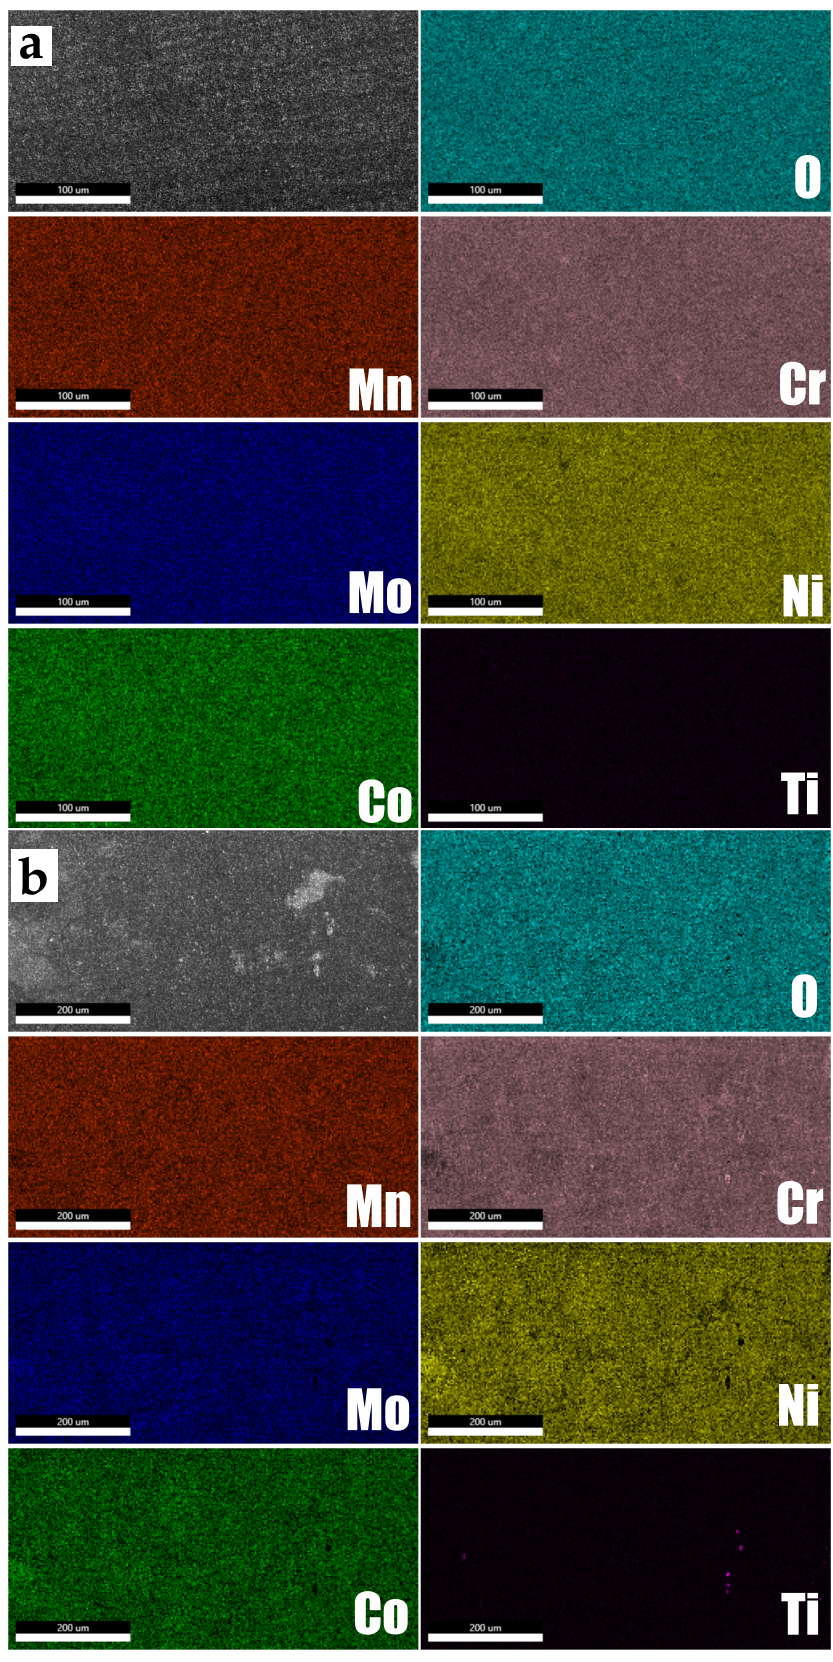
Figure 6. Surface SEM micrograph post-air-oxidation of: ( a ) IN 617 AR; ( b ) IN 617